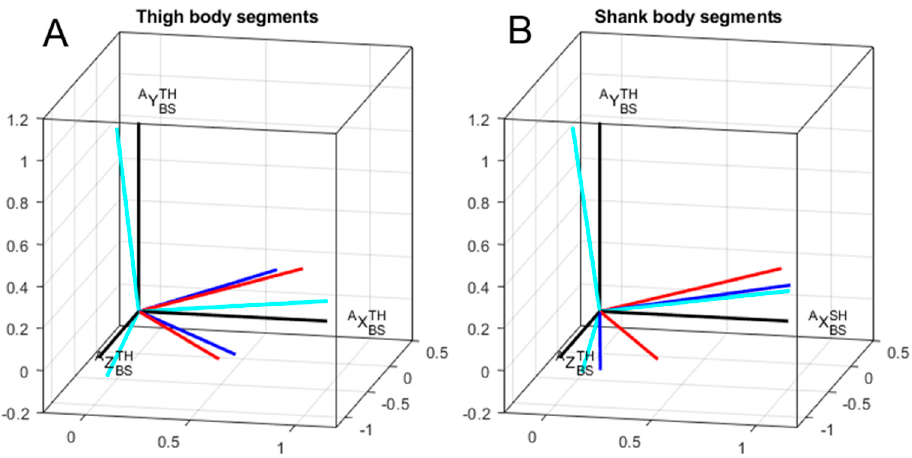
Figure 4. A typical example results for one participant concerning technical frames orientation for thigh ( A ) and shank ( B ) with respect to corresponding anatomical frames. Red: static method; blue: mixed method; cyan: cycling method; black: anatomical method. Table 3. Mean differences in body segment orientations using the anatomical and technical frames. Differences were expressed as the smallest rotation angles for thigh and shank. Differences were also expressed as Euler angles around the anteroposterior X -axis, longitudinal Y -axis, and medio-lateral Z -axis for the thigh and shank. ** denotes a significant difference, with p < 0.01. Orientation Error for Each Method (Deg) p -Values Segment Angle Static Mixed Cycling S vs. M S vs. C M vs. C TOTAL 20.0 ± 6.6